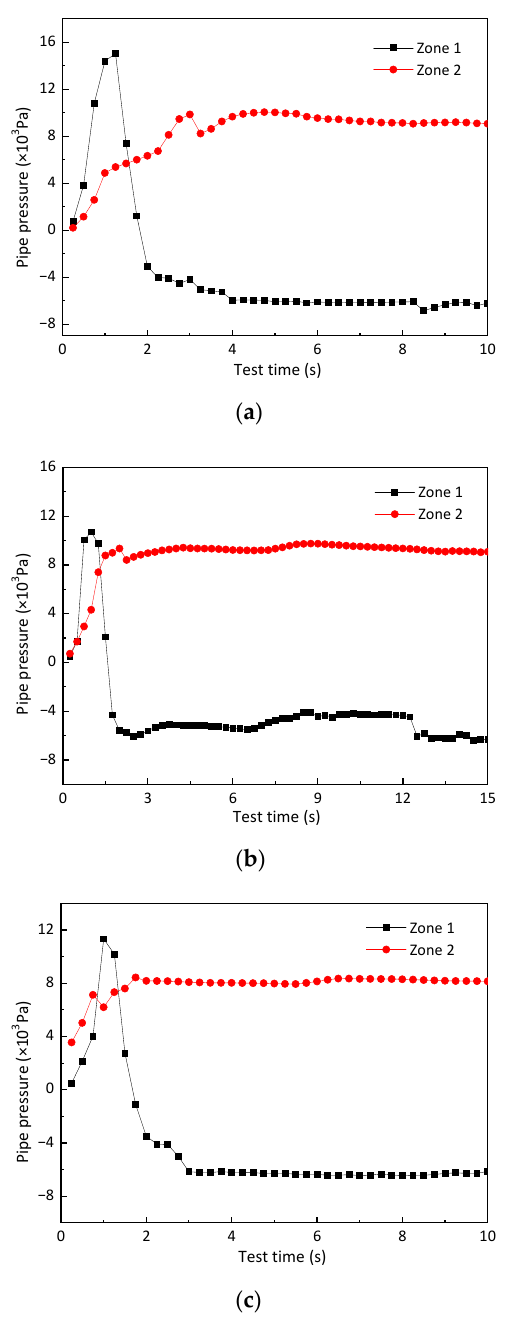
Figure 12. Pipe pressure with test time in the presence of ( a ) S1-78%; ( b ) S1-80% and ( c ) S2-80%.